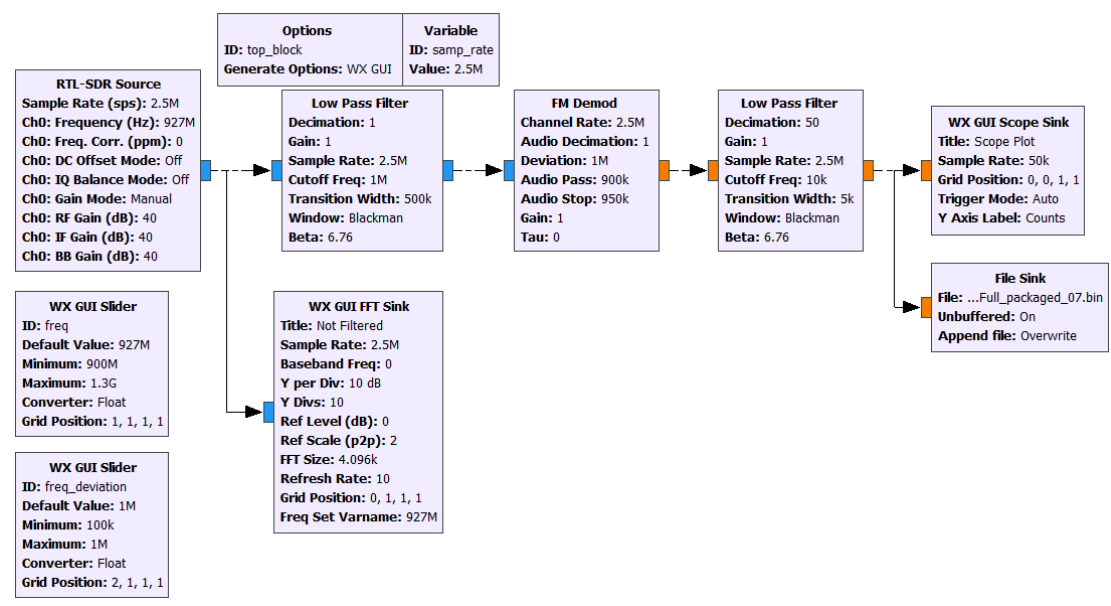
Figure 6. Screenshot of the GRC interface showing the different blocks that comprise the software-defined FSK receiver.